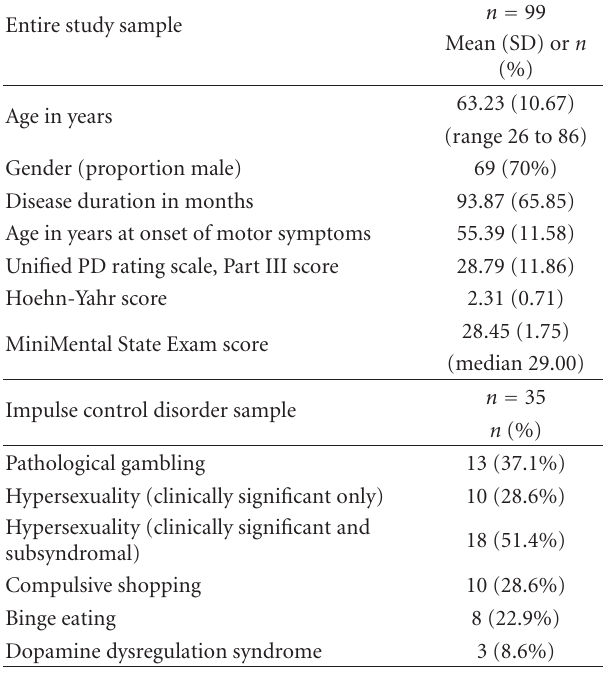
Table 1: Demographic and clinical description of the entire Parkinson disease (PD) study sample and proportion of impulse control disorder subtype within the “ICD”